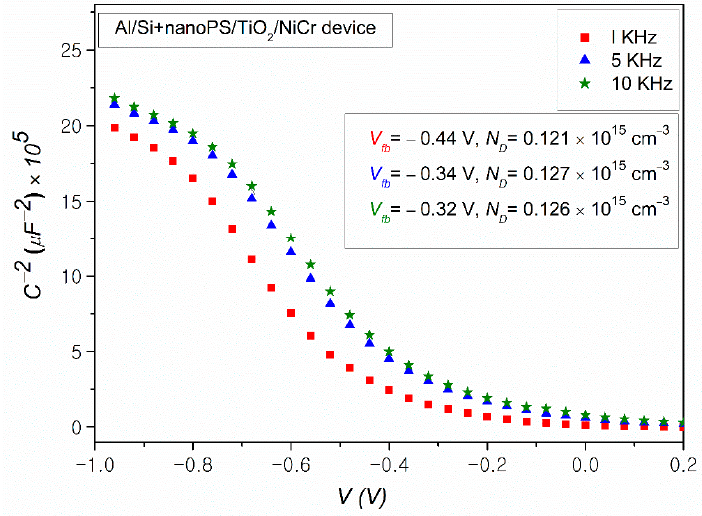
Figure 7. Mott–Schottky diagram for the Al/Si+nanoPS/TiO 2 /NiCr Schottky junction device, at 1, 5, and 10 KHz. The values calculated for V fb and N D are presented in the inset.